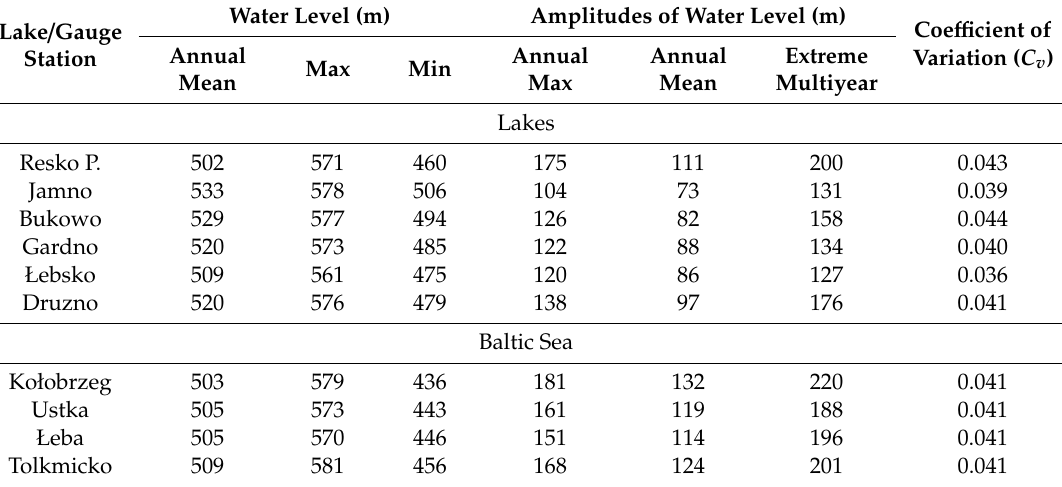
Table 2. Water levels and their amplitudes in the analyzed lakes and in the Baltic